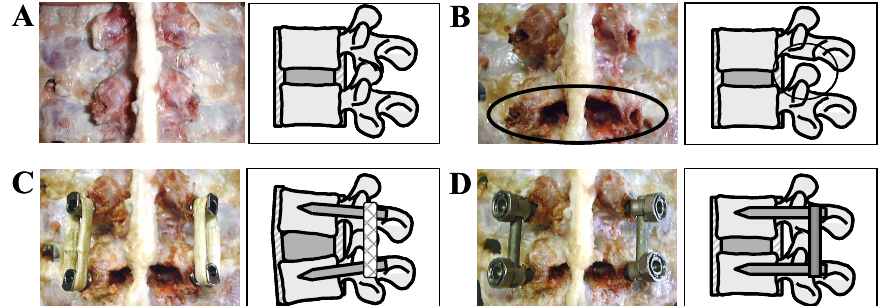
Fig. 1 Instrumented models of the porcine lumbar spine. Posterior view (left) and lateral view (right) of the specimens were shown. A: Intact spine. B: Bilateral medial facetectomy (MF). C: Graf flexible